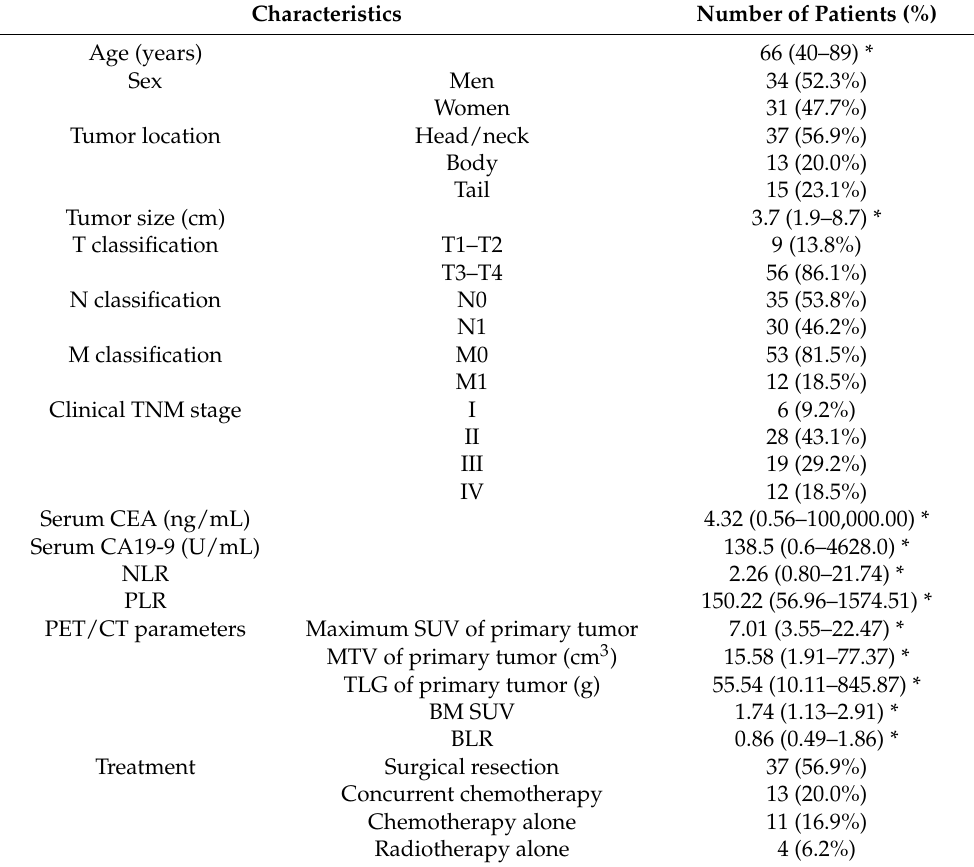
Table 1. Clinical characteristics of patients with pancreatic cancer ( n =